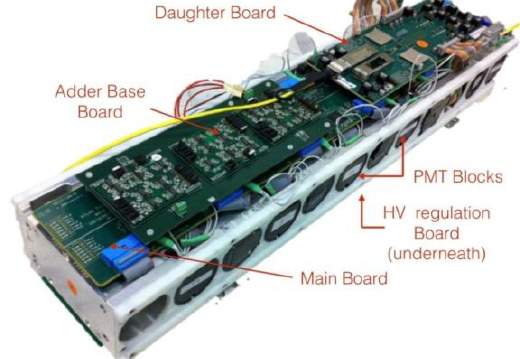
Fig.4. Picture of one assembled mini-drawer with all the on-detector electronics [4].